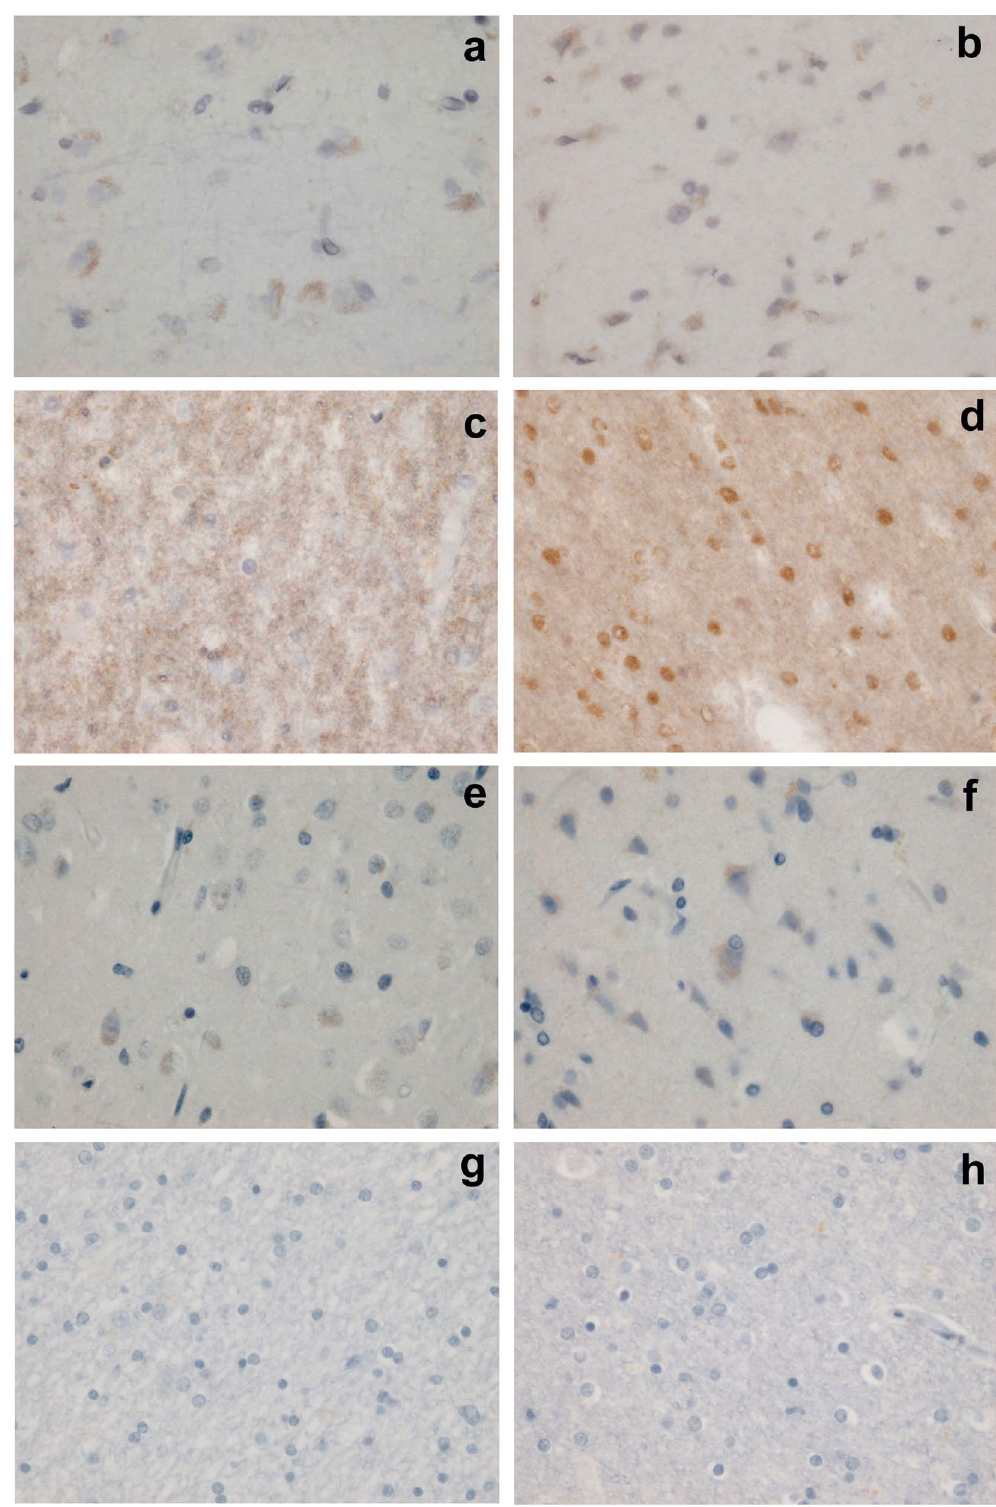
Figure 3. Immunohistochemistry for ER- β 1 ( a–d ) and ER- α ( e–h ) in the frontal lobe; cortex from an AD patient ( a,e ) and a control ( b,f ); white matter from an AD patient ( c,g ) and a control ( d,h